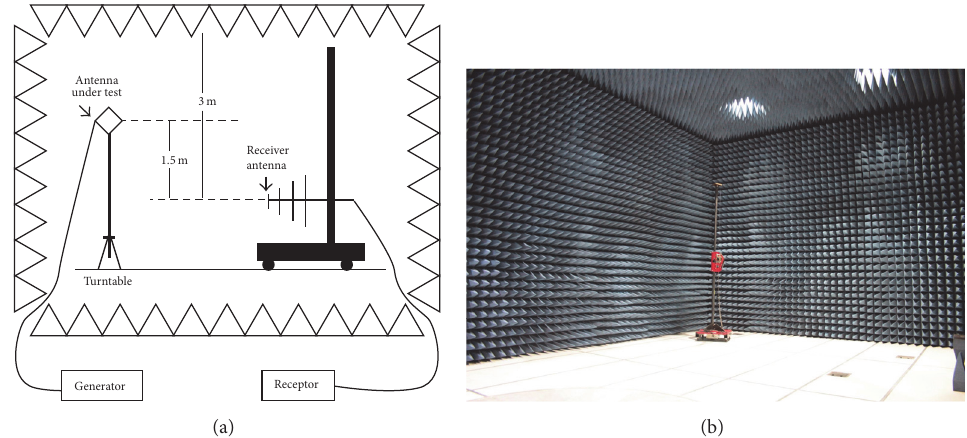
Figure 2: Experimental setup using an anechoic chamber: (a) diagram and (b) a photo of the inside of the chamber.